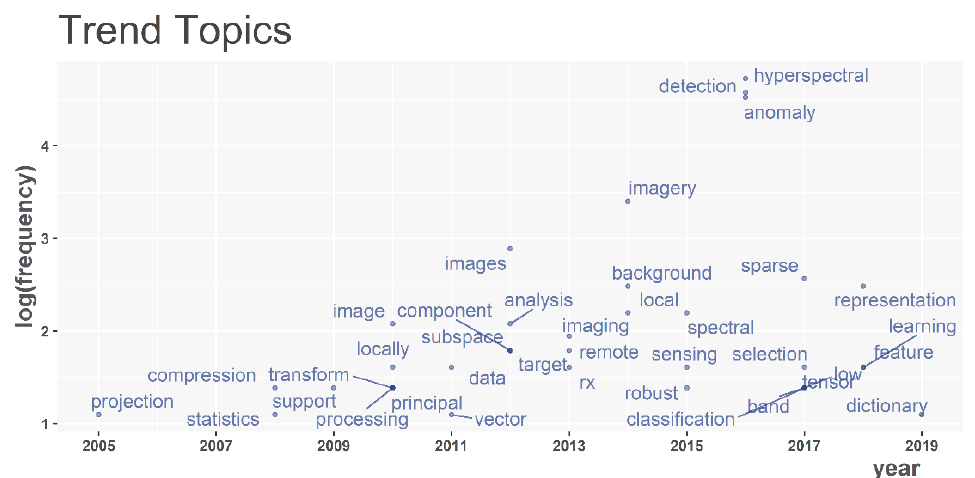
Figure 4. The development of the theme described by the title keywords. The graph represents the use of the most frequent title keywords (their frequencies are expressed on a logarithmic scale) over time. The figure was created using the bibliometrix R-package [23]. Table 6. The topic development expressed by the key author’s keywords over time. The most relevant keywords were filtered and manually selected by